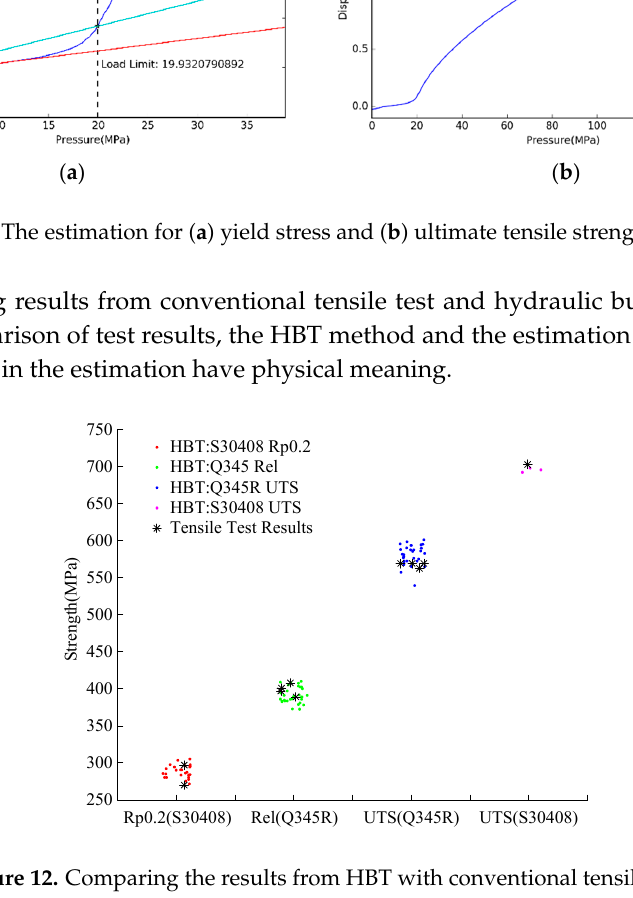
Figure 13. The HBT curves of four different materials. Table 2. The data for strength estimation. Specimen